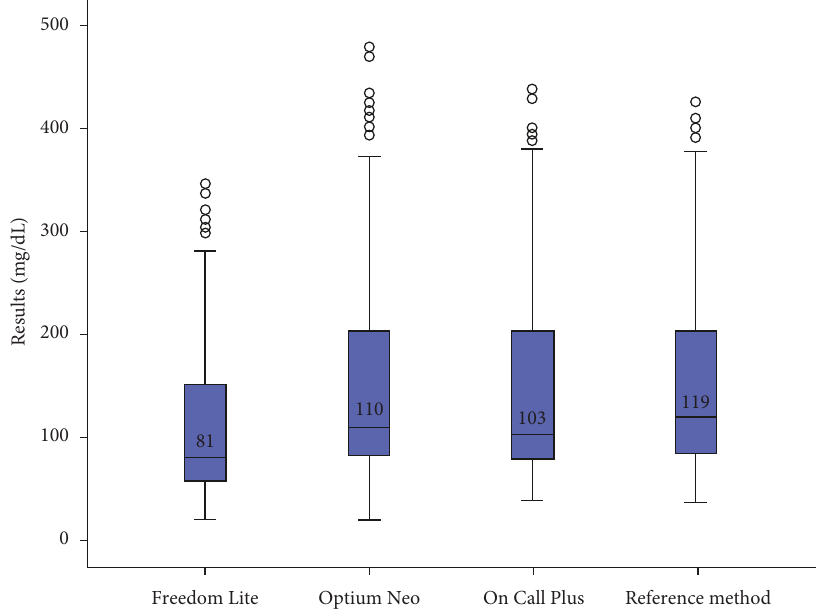
Figure 1: Boxplot of blood glucose values obtained using glucometers and the reference method in